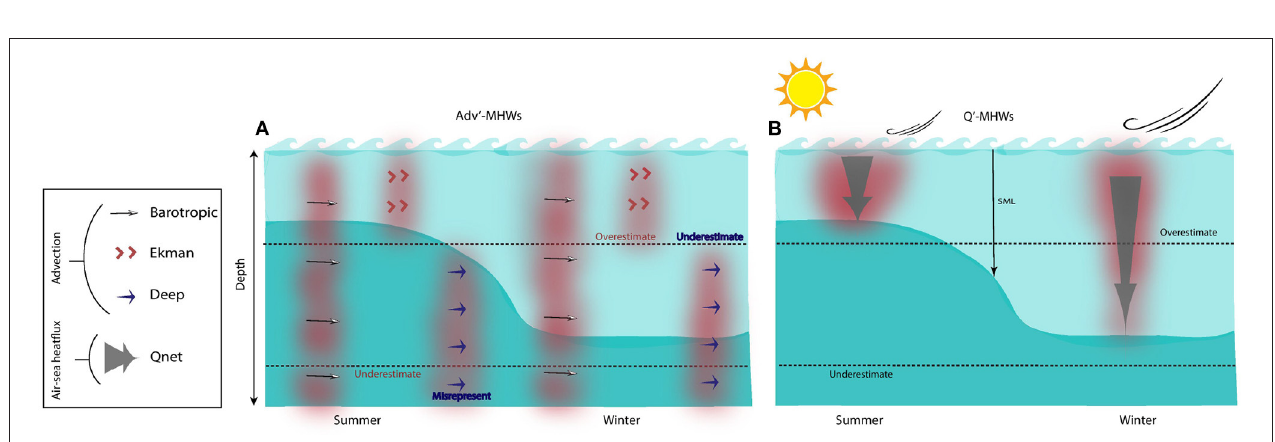
FIGURE 12 | Impact of seasonality on dominant driver classification of MHWs in the Eddy (A,C,E) and NZ (B,D,F) boxes. Mean annual air-sea heatflux is shown with thick black lines in panels (A,B) with gray lines illustrating the annual variability in the 1985–2014 (inclusive) period. Mean MLD is shown in panels (C,D) with annual variability also marked with gray lines. (E,F) show the number of MHWs identified as Q’-MHWs (solid lines) and Adv’-MHWs (dashed lines) in MLD 30 (blue), MLD V (red), and MLD 150 (green) during each month.